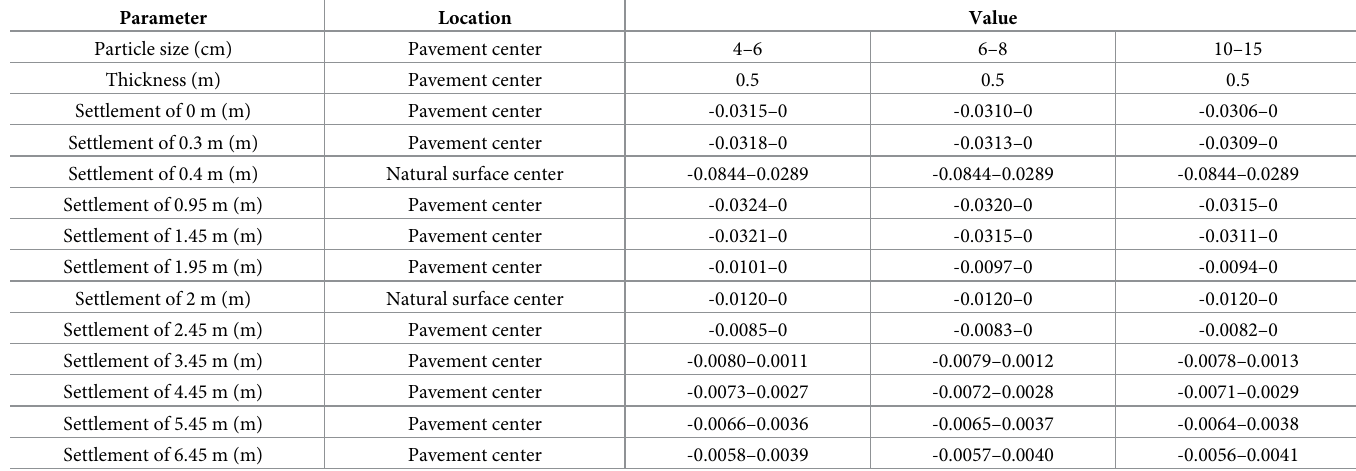
Table 11. Settlement of varied subbase